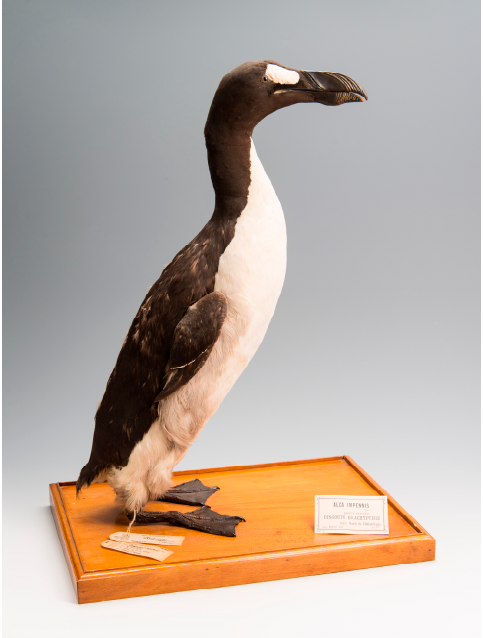
Figure 1. A mounted Great Auk skin, The Brussels Auk (RBINS 5355) (MK135), from the collections at Royal Belgian Institute of Natural Sciences (Credit Thierry Hubin (RBINS)).